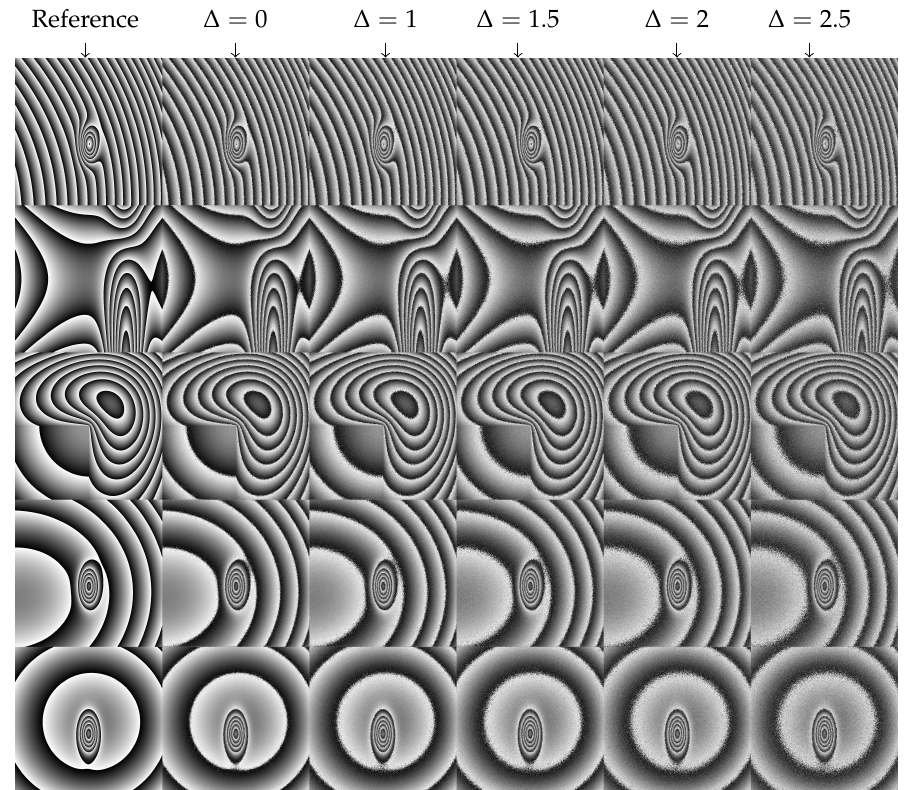
Figure 1. HOLODEEP training phase images: five patterns ( in lines ) with simulated speckle noise with five values of ∆ ( in columns